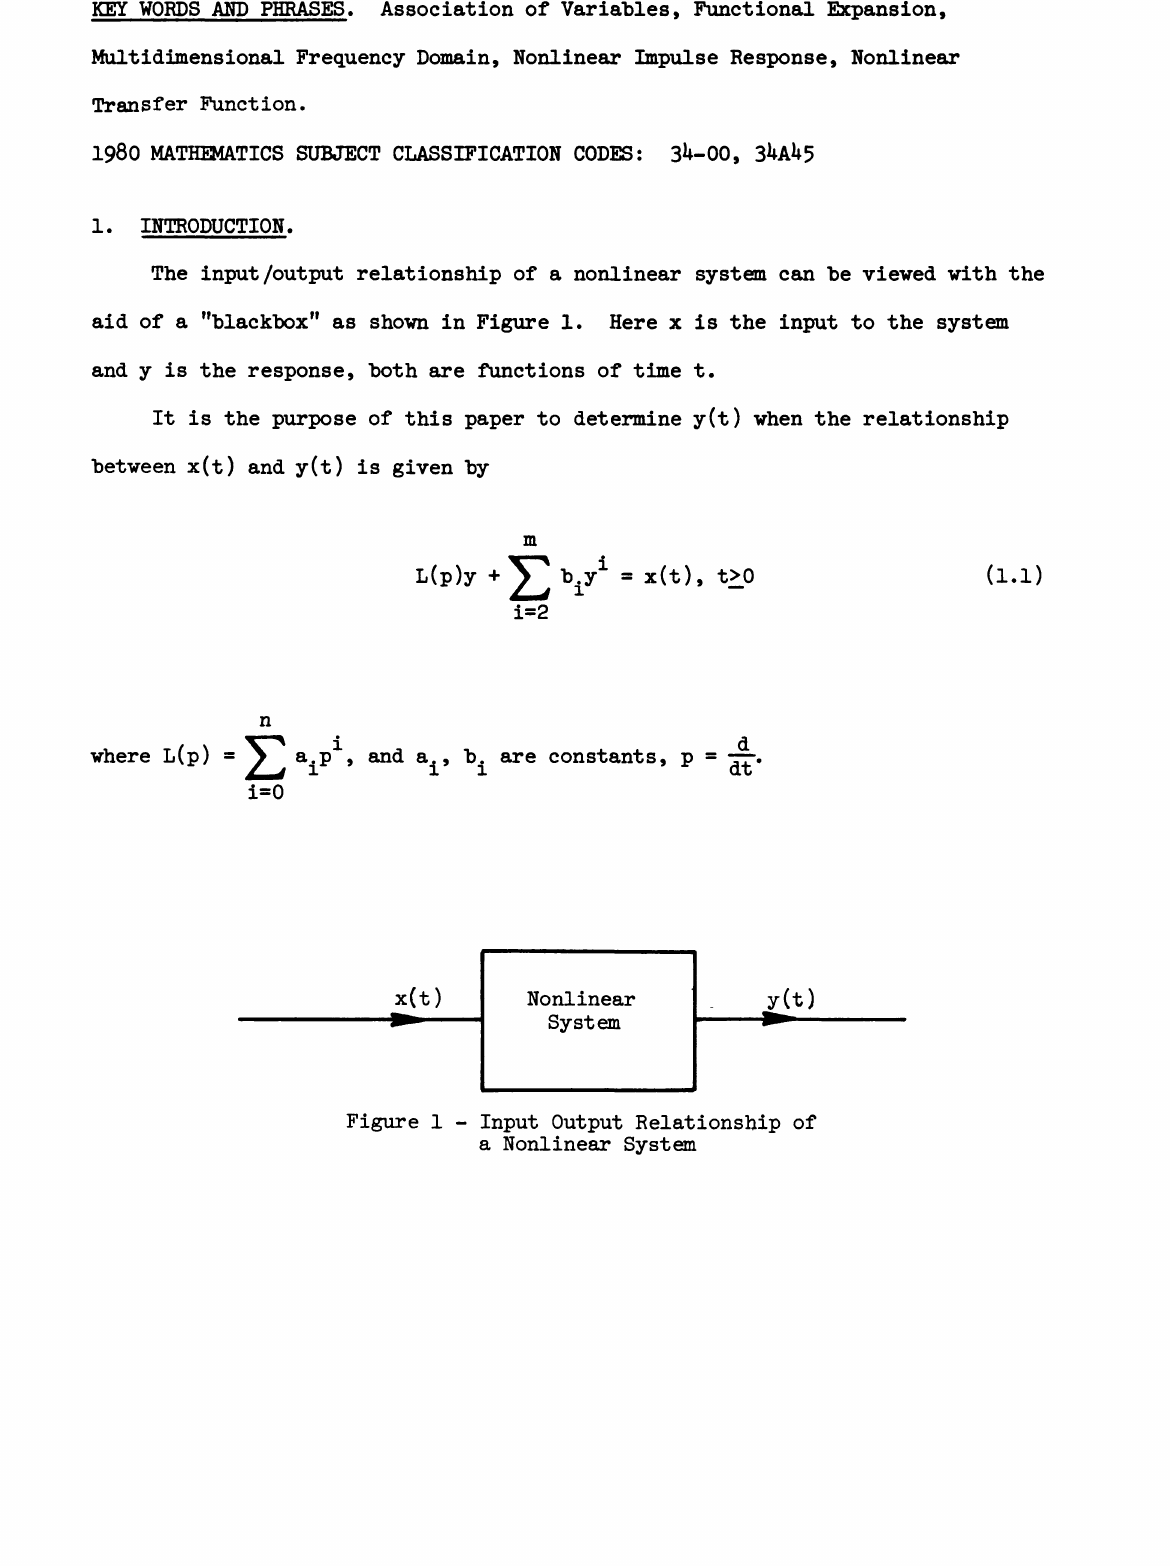
Figure i Input Output Relationship of a Nonlinear